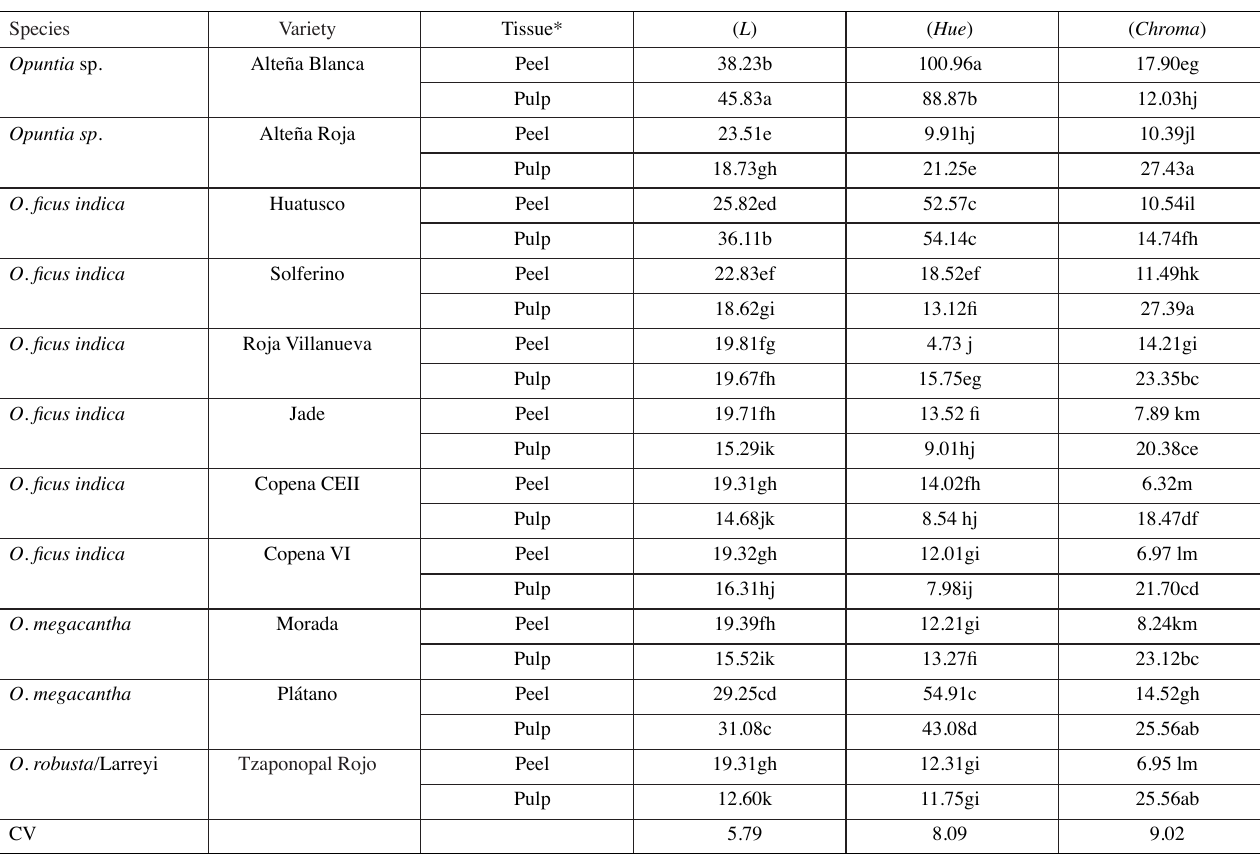
Tab. 4: Color parameters of the fruit of 11 varieties and species of prickly pear ( Opuntia sp.) harvested at the Universidad Autónoma Chapingo Experimental Station, Chapingo, Mexico. Species Variety Tissue* Opuntia sp. Opuntia